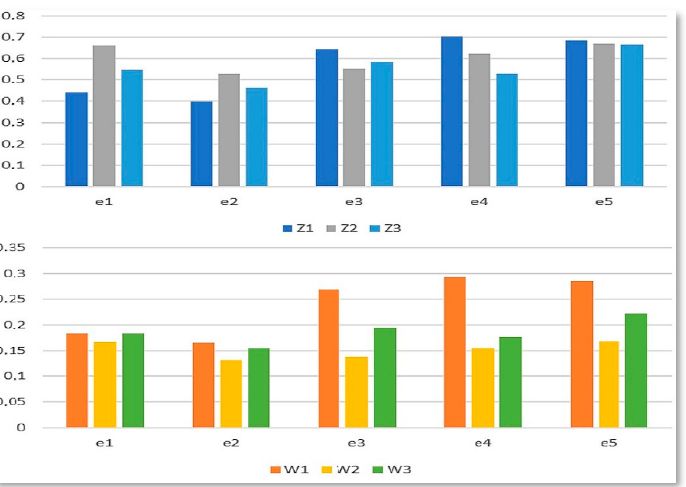
Figure 5. Values of neuronal excitation level ( (cid:1852) (cid:2869) ; (cid:1852) (cid:2870) ; (cid:1852) (cid:2871) ) and postsynaptic potential function ( (cid:1849) (cid:2869) ; (cid:1849) (cid:2870) ; (cid:1849) (cid:2871) ). W 2 ; W 3 ).